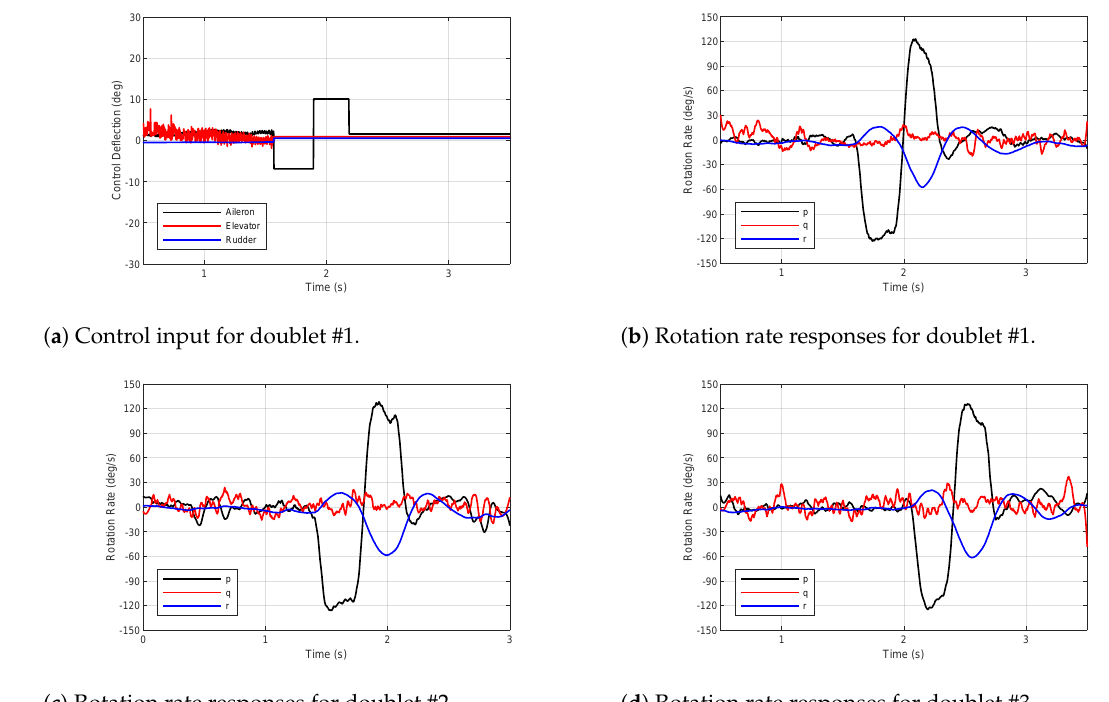
( d ) Rotation rate responses for doublet #3. Figure 5. The ( a ) control input and ( b – d ) rotation rate response time history for 3 automated aileron doublets; note that ( b ) is the response for input ( a ) and that ( c , d ) are responses for inputs with identical square waves as ( a ) that are slightly time